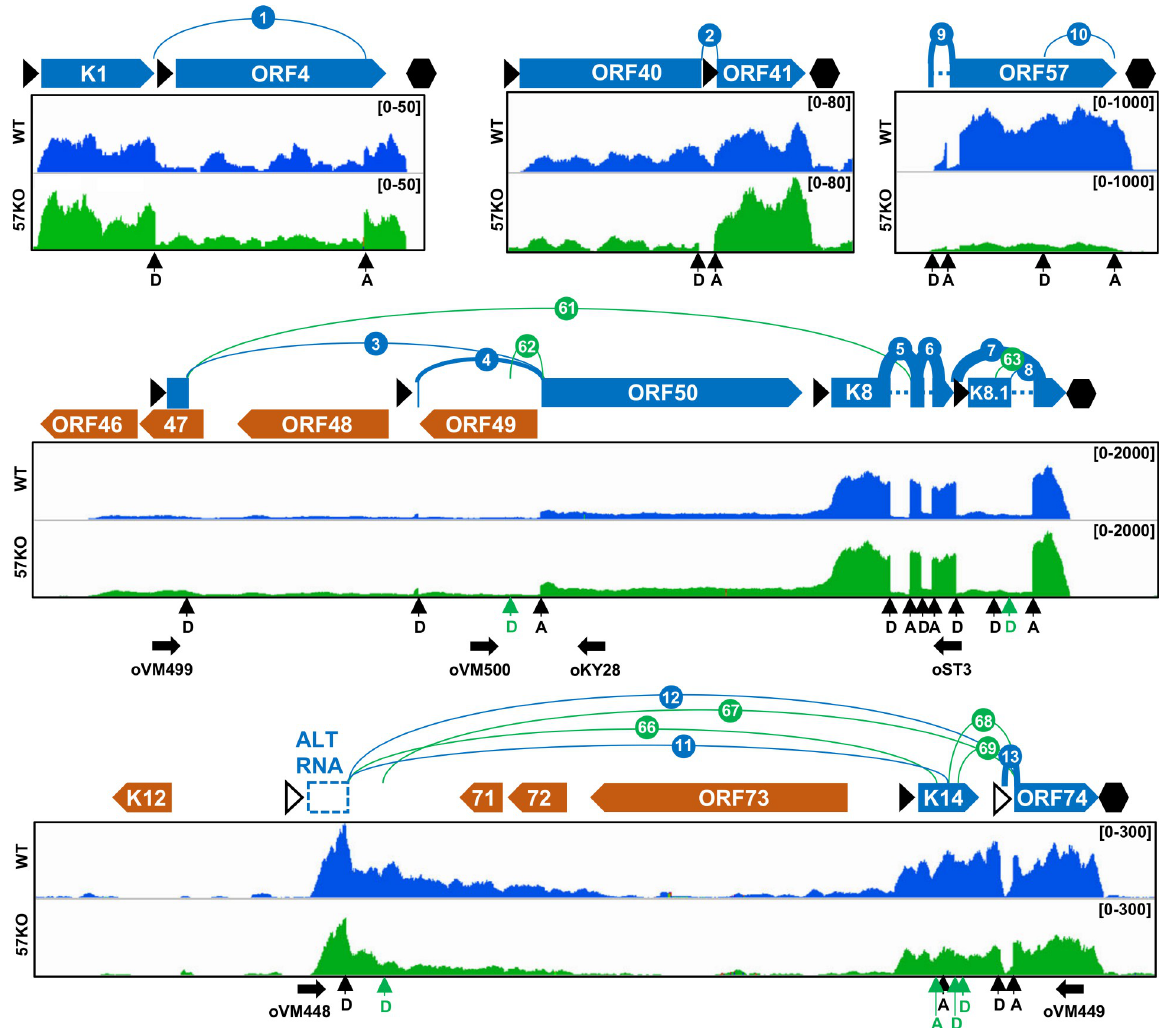
Fig 3. Mapping of KSHV RNA splice junctions from the plus strand of viral genome. The diagrams depicting all splice junctions (colored arches) with � 10 supporting splice reads mapped to viral transcripts expressed from the plus strand of the KSHV genome, with the splicing events being numbered in the order from the genome 5 0 to 3 0 direction. The numbered blue arches represent splice junctions detected from the WT genome and green from the 57KO genome in the cells (see Tables 1 and 3 ). The arch thickness represents a relative abundance of detected splice junction reads. The RNA-seq reads-coverage from one representative sample from the WT and 57KO genome in the cells with lytic infection is shown below the arches, with the reads-coverage depth shown in the upper right corner. The annotated KSHV ORFs are marked by full arrows, blue for ORFs encoded from the plus or orange for ORFs from the minus DNA strand. The dashed boxes are predicted non-coding exons. The black triangles represent mapped (full) or predicted (empty) transcriptional start sites [9, 10]. The black hexagons mark the mapped polyadenylation cleavage sites [8]. The 5 0 splice donor (D) and 3 0 splice acceptor (A) sites are marked with vertical arrows. Horizontal arrows mark the positions of primer sets used in RT-PCR.